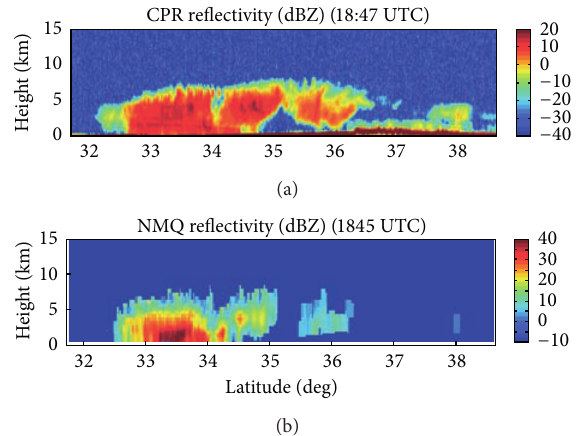
Figure 2: Reflectivity cross-sections from (a) CloudSat CPR and (b)